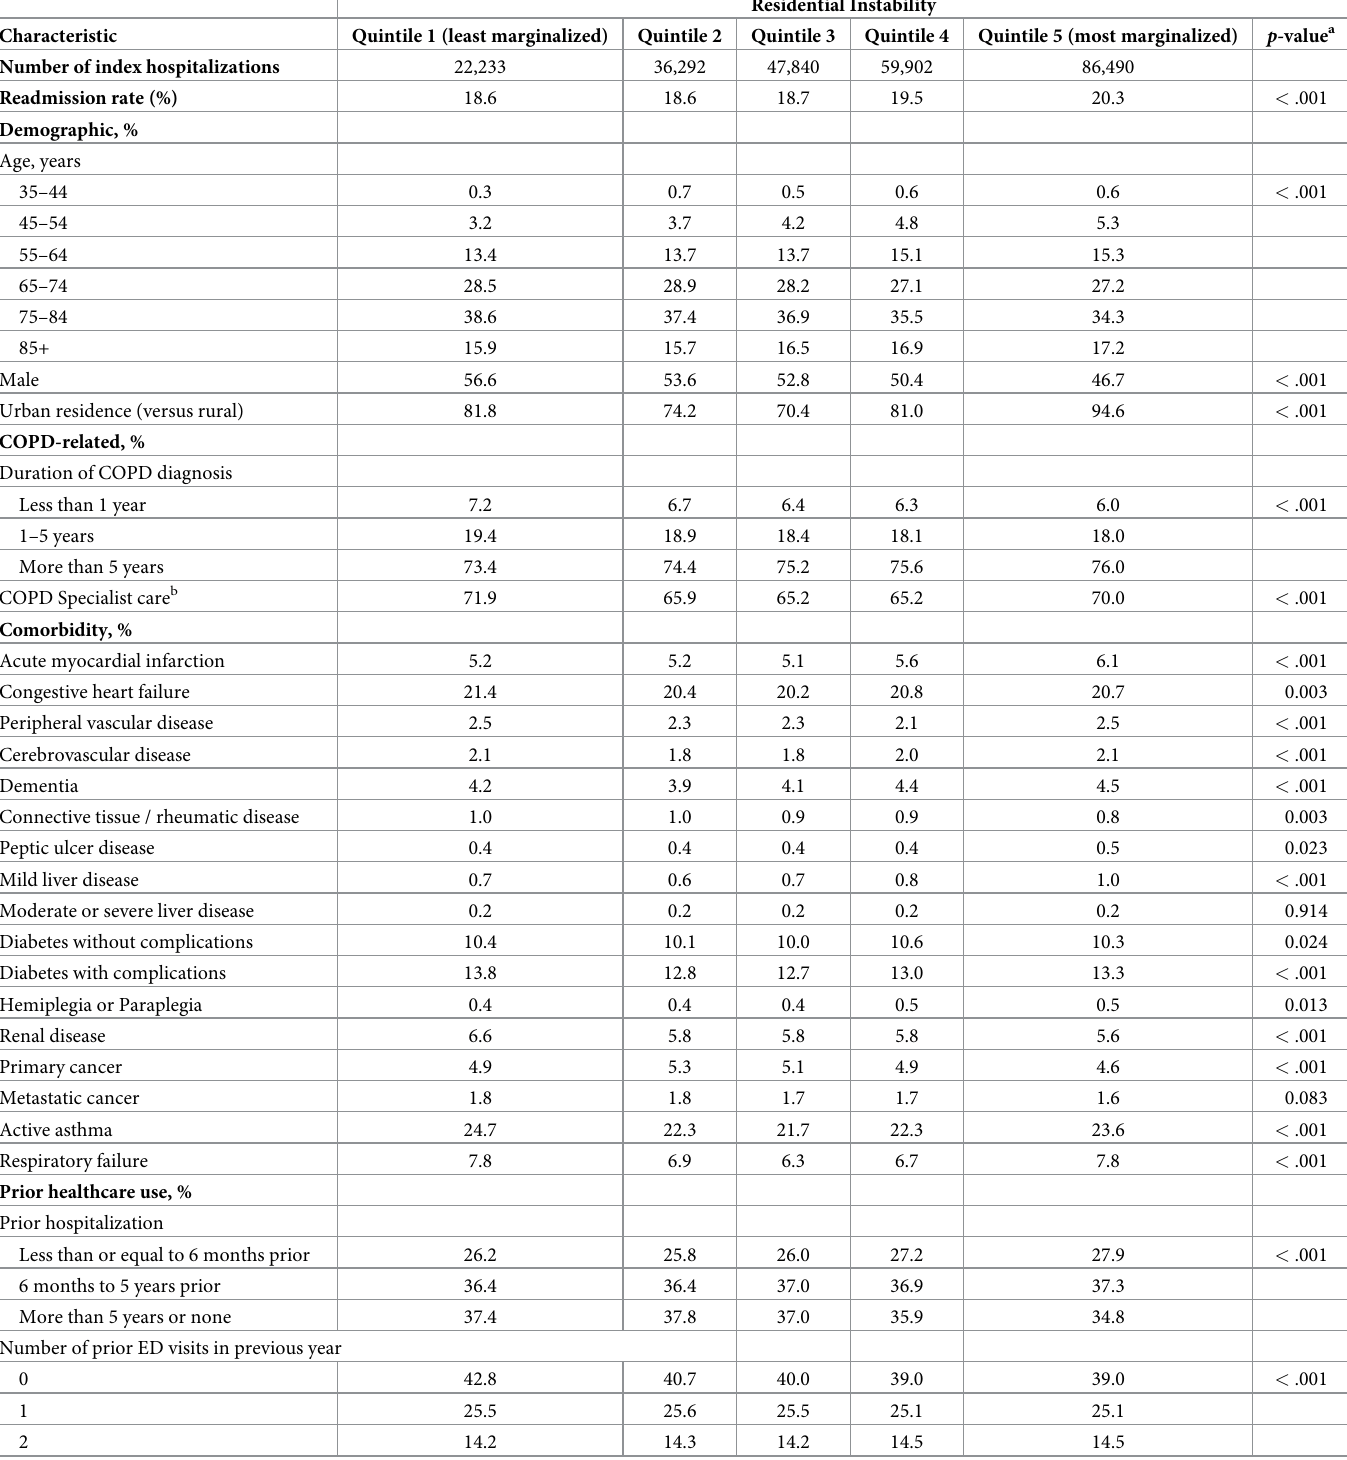
Table 1. Characteristics of patients with COPD hospitalizations by socioeconomic status as reflected by residential instability, a domain of the Ontario Marginali- zation